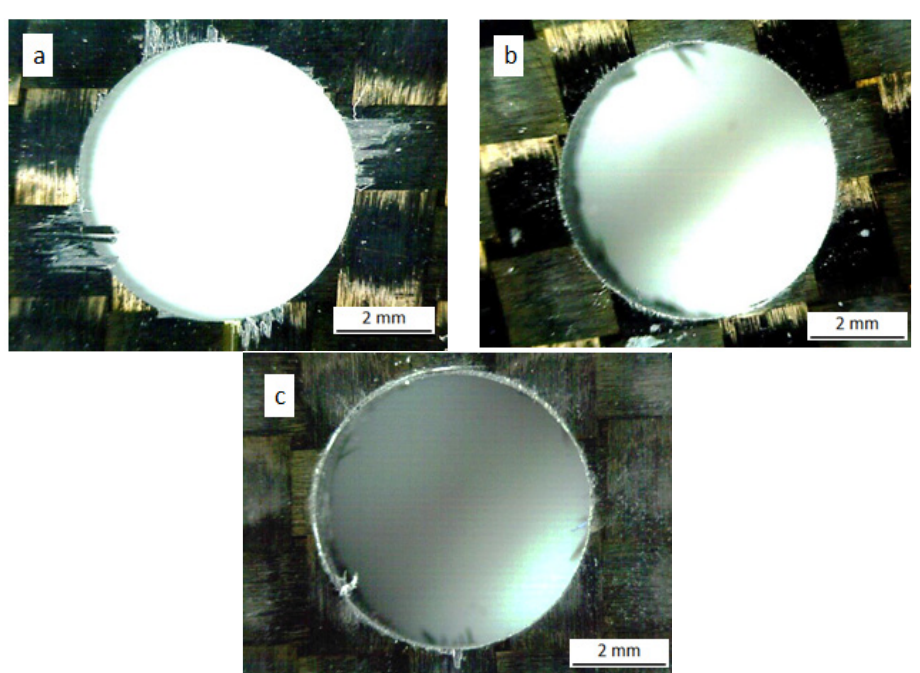
Figure 5. Peel up delamination at the hole entrance for new tool ( a ), flank wear tool ( b ) and honed edge tool ( c ) with point angle 118°, V = 50 m/min and f = 0.05